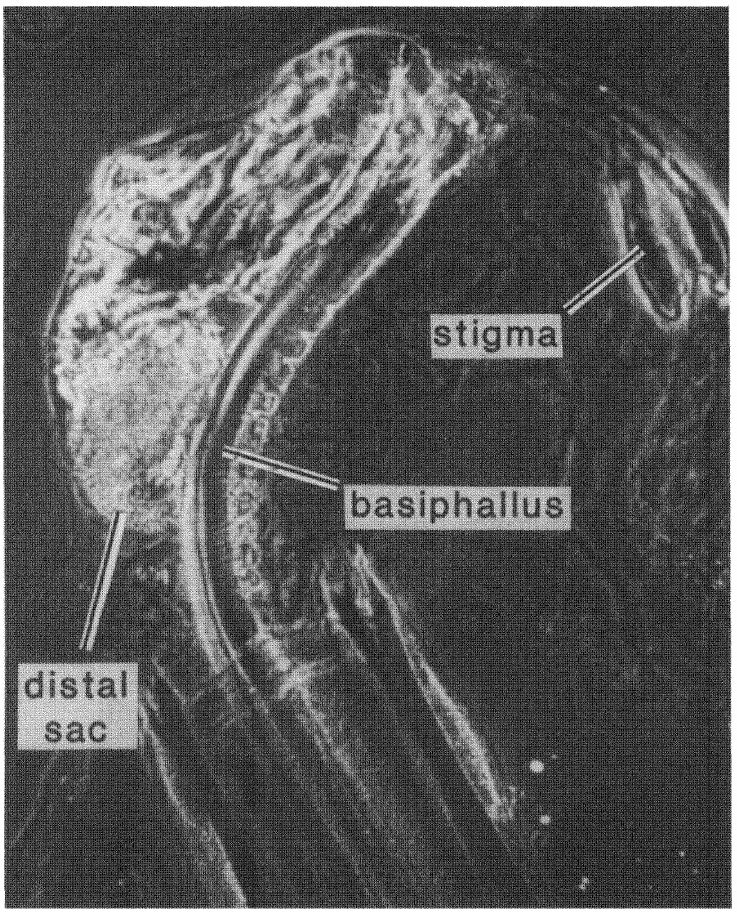
Fig. 10. Wholemount of the aedeagus of a male in the vagina of a female poste- rior to the stigma after 2 min of genital contact. The male’s distiphallus is folded back 180 to lie along the terminal portion of the